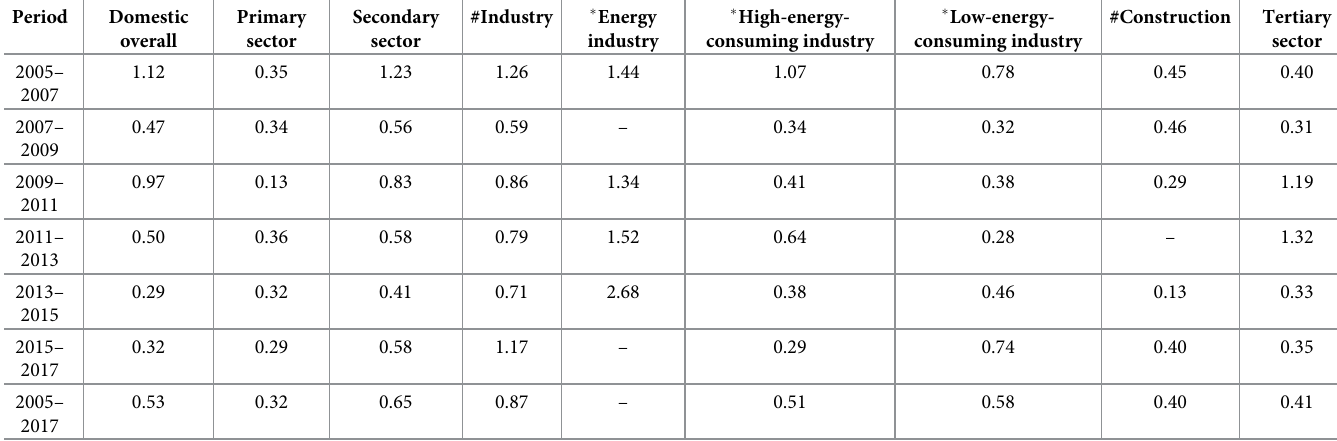
Table 5. Energy rebound effects of China’s domestic overall, the three sectors, and various industries within the secondary sector during 2005–2017. Period Domestic